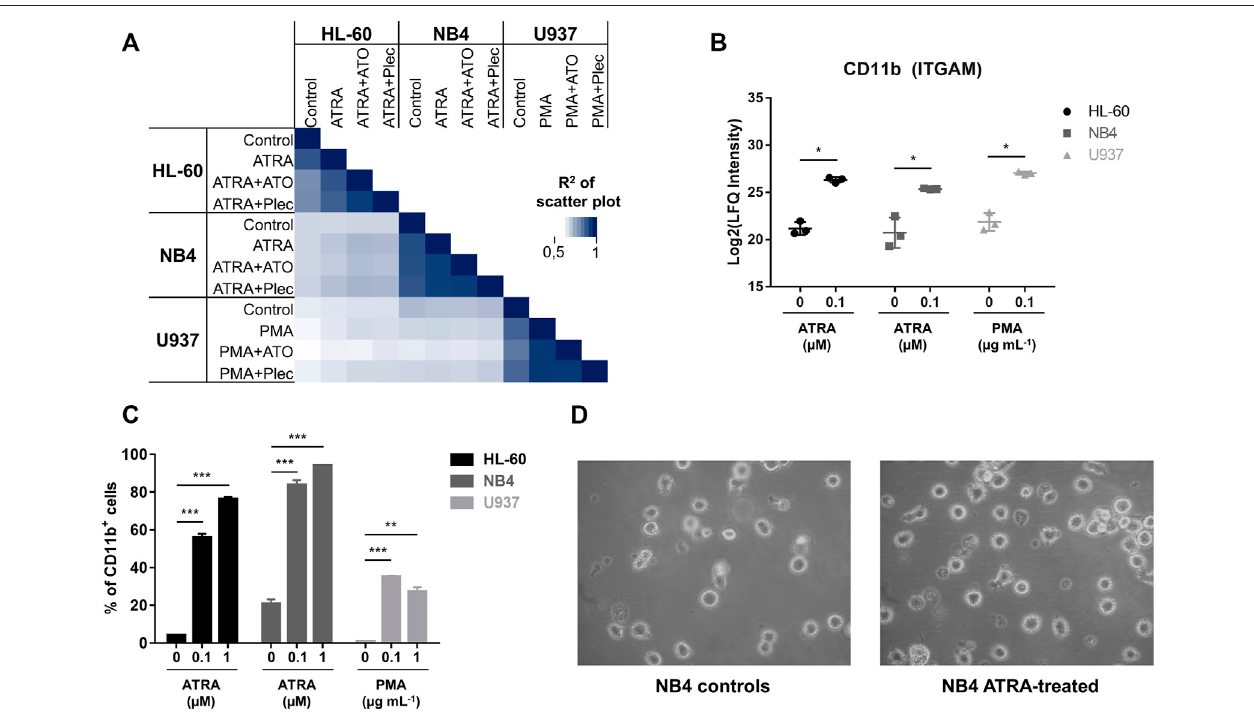
FIGURE 2 | (A) Multi-correlation plot displaying the R 2 -correlation among all investigated conditions. The abundances of cytoplasmic proteins were used. Biological triplicates of each condition were averaged to the mean . (B) Intracellular protein abundance of CD11b (ITGAM) in the cytoplasmic fraction of the three AML cancer cell lines according to differentiation with either ATRA or PMA for 48 h. Signi fi cance: * (cid:1) multi-parameter corrected signi fi cant regulation. (C) Flow cytometric analysisofCD11b + cells(surfaceexpression)inallthreeAMLcancercelllinesindependenceofATRA(PMA)treatment.Thecellsweredifferentiatedfor48 h.Three biological replicates were analysed. Signi fi cance: * p -value < 0.05, ** p -value < 0.005 and *** p -value < 0.0005. (D) Representative light microscopy images (Zeiss) of control and ATRA-treated NB4